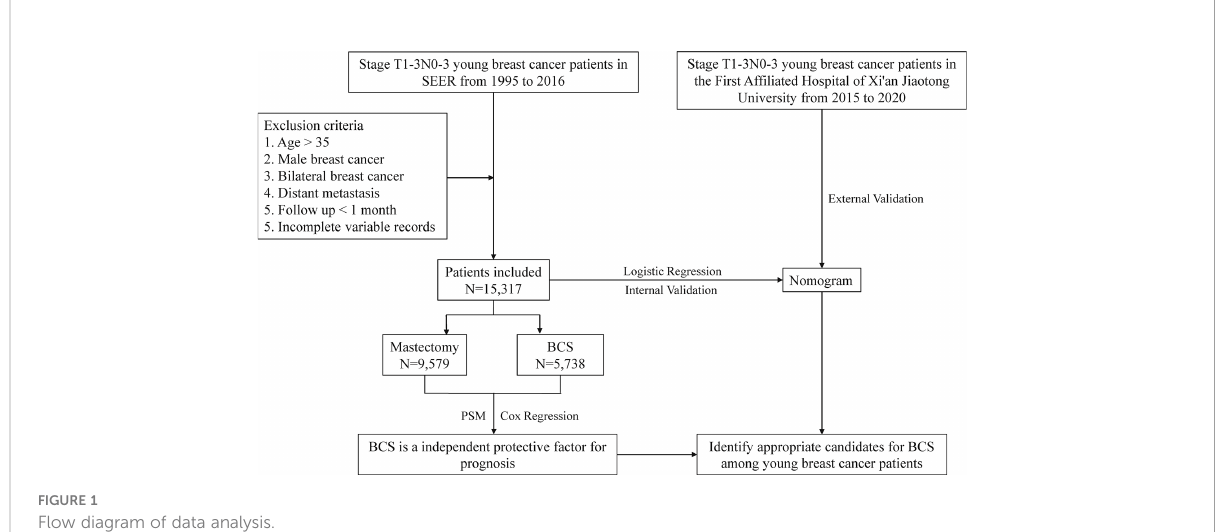
FIGURE 1 Flow diagram of data